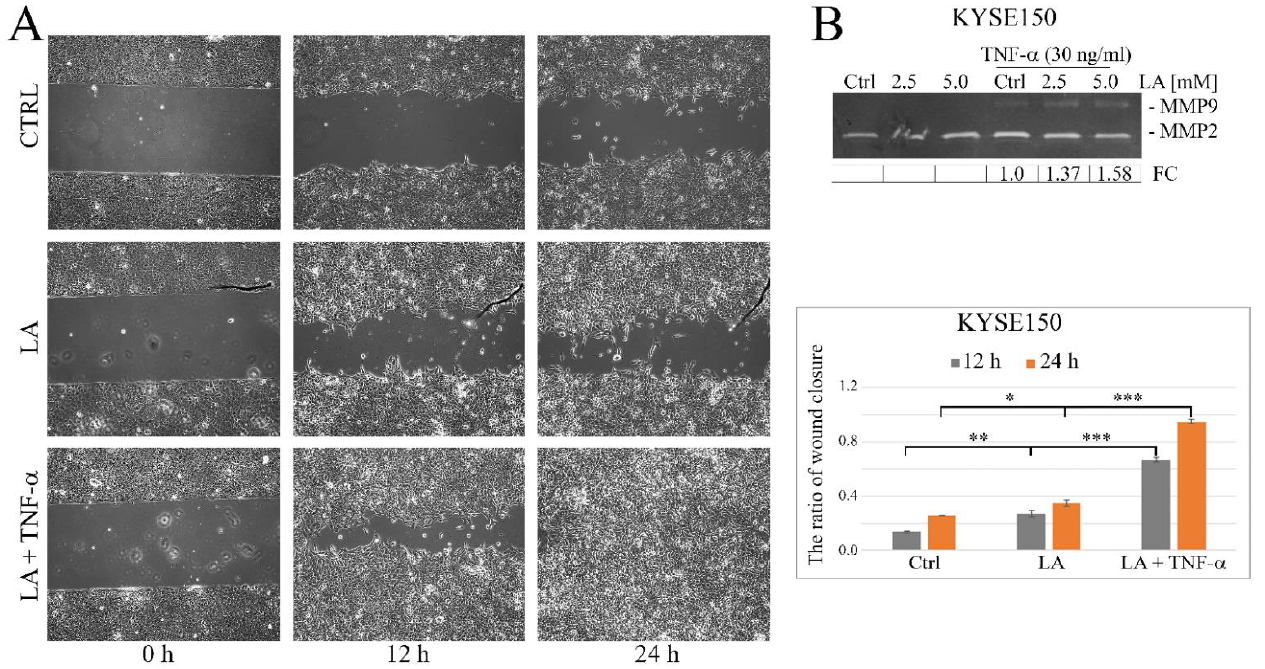
Figure 9. Effect of sodium lactate (LA) on TNF- α -induced MMP9 expression and cell migration in esophageal cancer cells. ( A ) Representative images from wound healing assay showing the changes in KYSE150 cell migration under LA applied separately and in combination with TNF- α after 12 h and 24 h of treatment. Quantitative analysis from the wound healing assay showing the ratio of wound closure in control cells and LA-treated cells, stimulated or not with TNF- α for 12 h and 24 h (bar graph). ( B ) LA-associated enhancement of TNF- α -induced upregulation of MMP9 in KYSE150 cells, as seen by gelatin zymography. FC — fold change calculated from differential densitometry of signals from two zymograms; Ctrl — control; LA — lactic acid; * p < 0.05, ** p < 0.005, *** p < 0.0005.